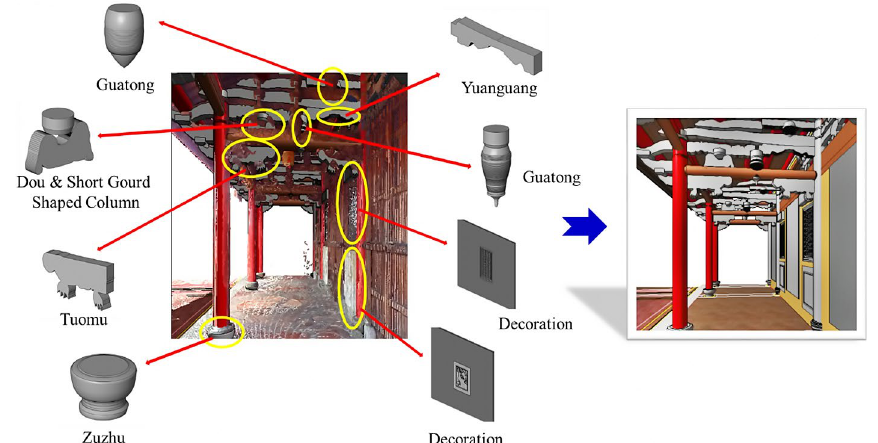
Figure 7. Layering of Shanman components with point cloud, and final assemblage